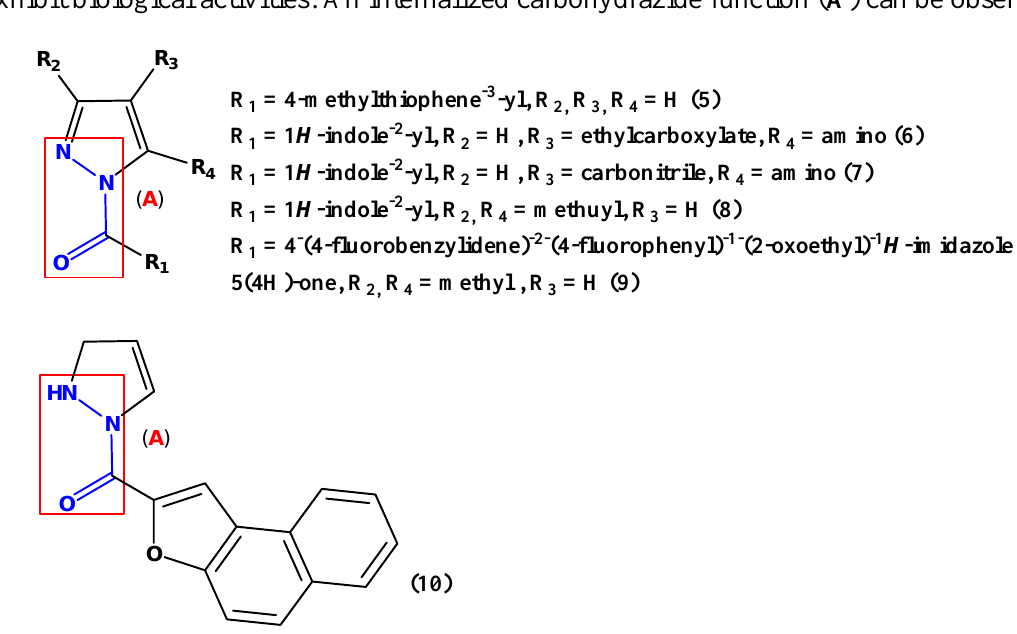
Figure 2. 1- H -pyrazole derivatives 5 – 9 and 2,3-dihydro-1- H -pyrazole derivative 10 that exhibit biological activities. An internalized carbohydrazide function ( A ) can be observed.